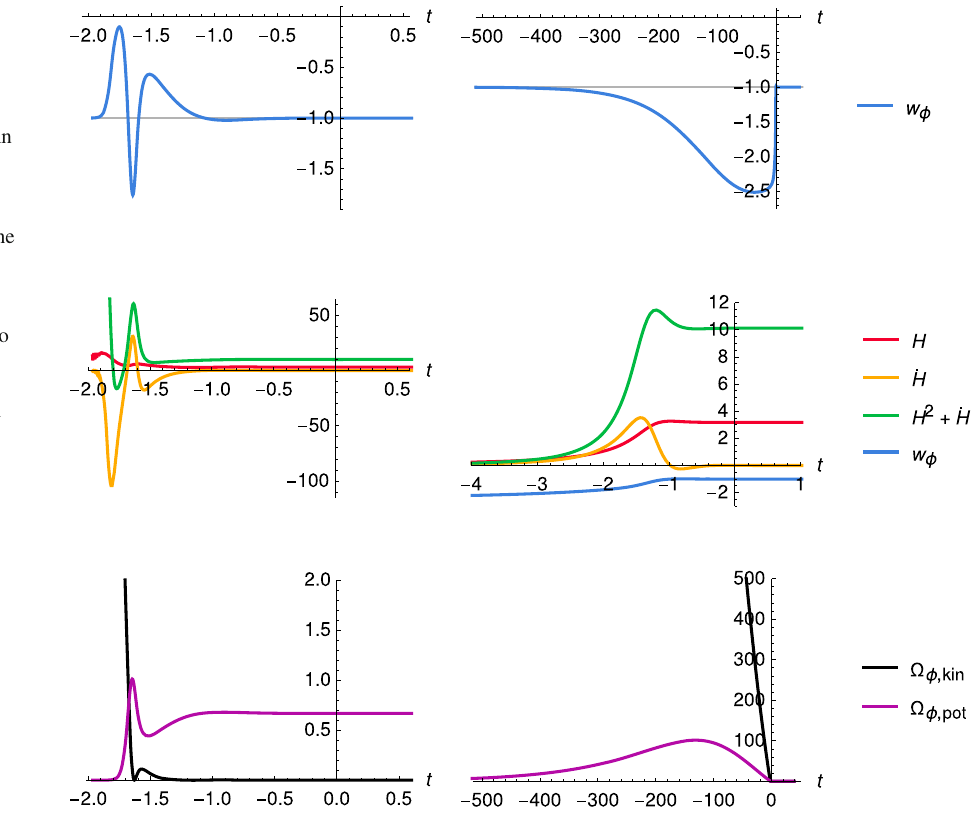
Fig. 14 The evolution of physical quantities over the cosmological time t for the evolutionary scenario (a) with values of parameters ξ = 3 , 16 n = 2, ε = + 1. The left column corresponds to orbits passing near the equilibrium point I (plots presented in the left column are for the orbit with the boundary conditions U (τ = − 3 . 7 ) = − 0 . 3, V (τ = − 3 . 7 ) = 0 . 92), while the right column corresponds to orbits passing near the equilibrium point C (the plots presented are for the orbit with boundary conditions U (τ = − 910 ) = − 0 . 822, V (τ = − 910 ) = 0 . 012). The time t as well as the quantities H , H 2 and ˙ H have been calculated in units for which √ M n + 4 (κ/ 6 ) n + 2 =